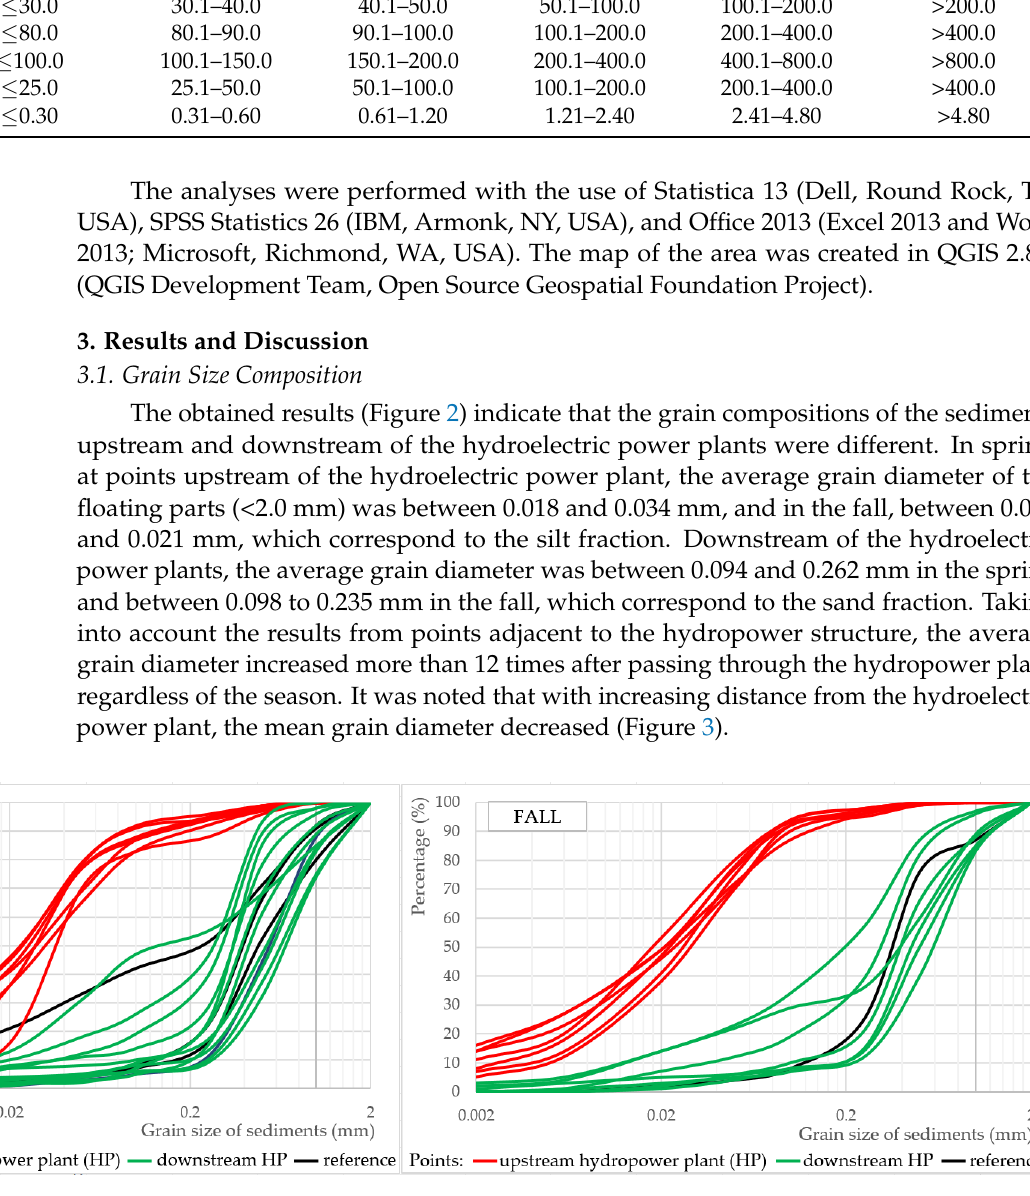
Figure 2. Percentage of the sediment fraction with different grain sizes near the hydropower plant on the Ślęza River.